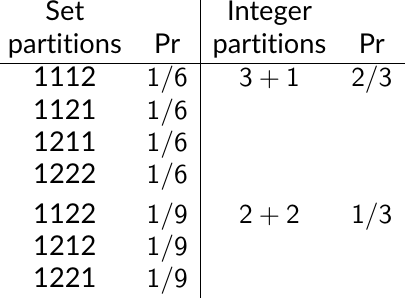
Table 1 – Set partitions, integer partitions, and their probabilities, for the case in which n = 4 and k = 2 . Under “set partitions,” the value in position j of each string is the index of the ancestor of descendant j . Thus, “1122” means that descendants 1 and 2 descend from one ancestor, whereas 3 and 4 descend from another. Ancestors are numbered in order of their appearance in the list of descendants. Integer partitions are discussed in section A.2 of the appendix. Set